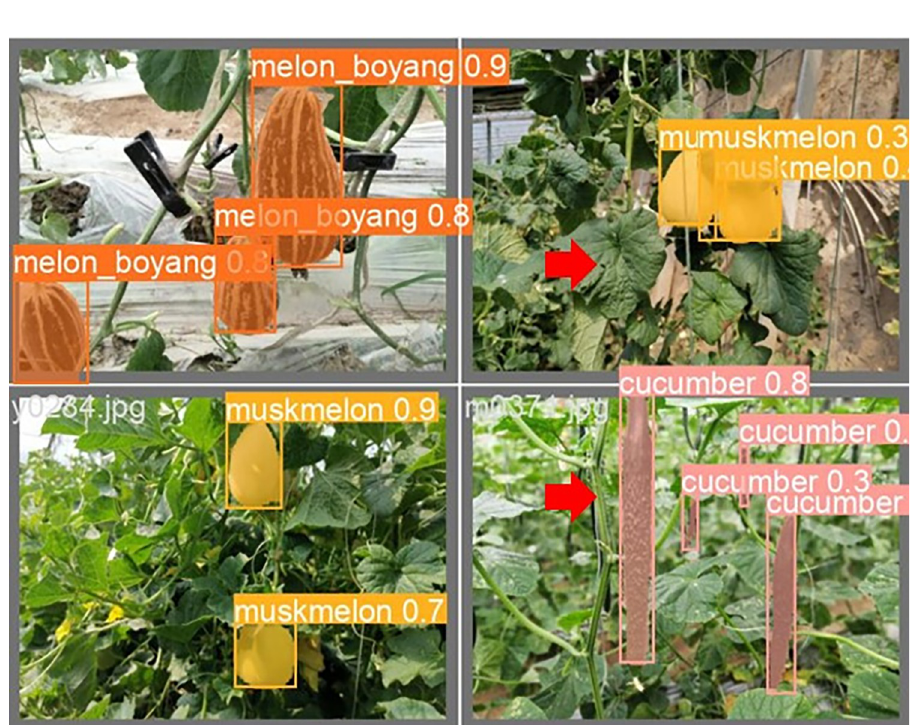
Fig 11. Image results of